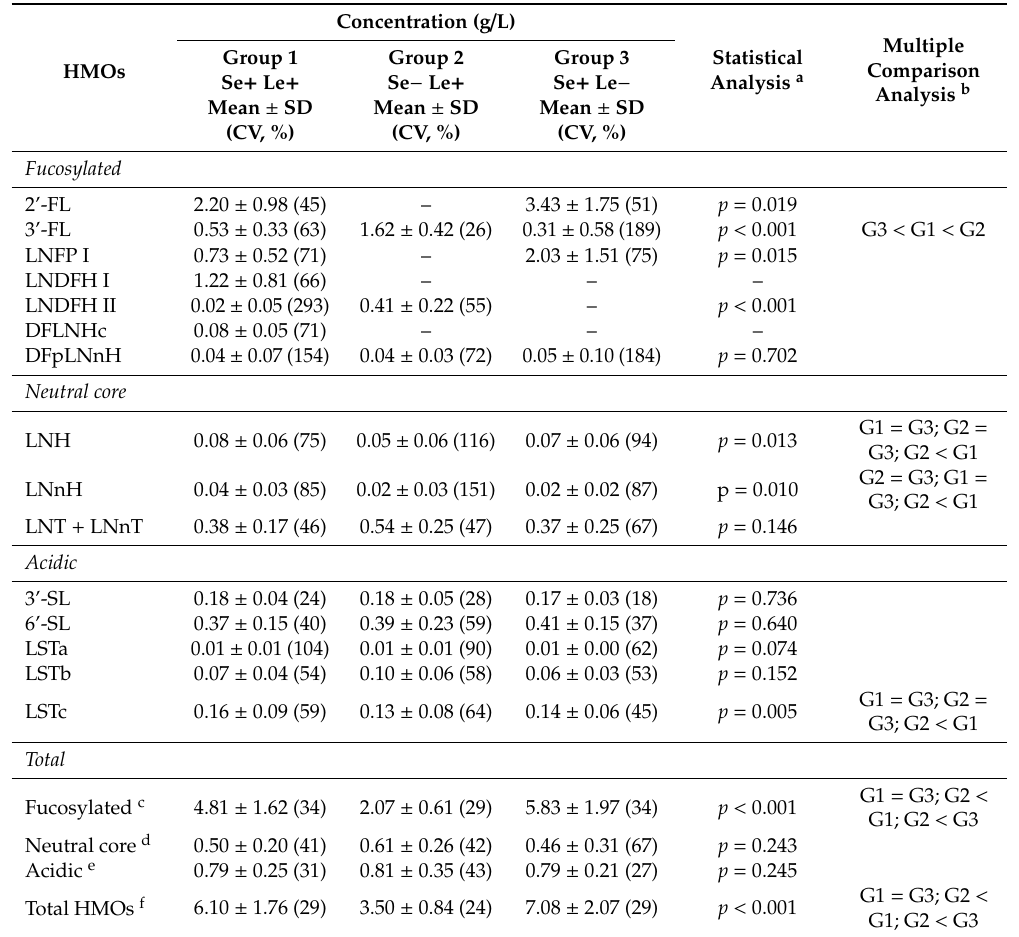
Table 4. HMOs concentrations in term mature human milk samples ( n = 77) according to the SeLe phenotypes of the lactating